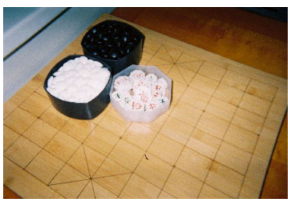
Figure 6. Korean